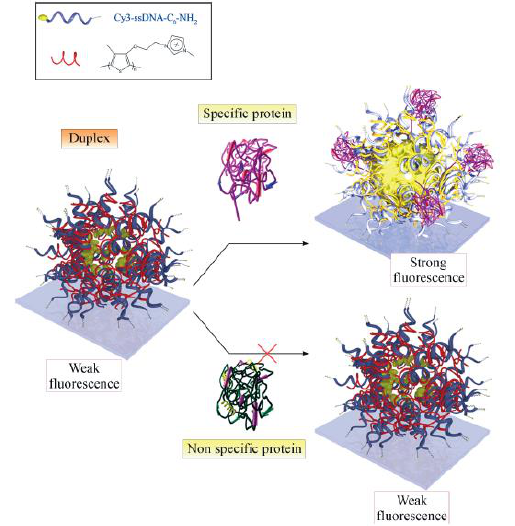
Figure 9. Description of the specific recognition of target proteins by single-stranded DNA (ssDNA) – polythiophene aptamer duplex aggregates on glass slides. Reprinted with permission from ref. [64]. Copyright 2006, Adv. Mater.